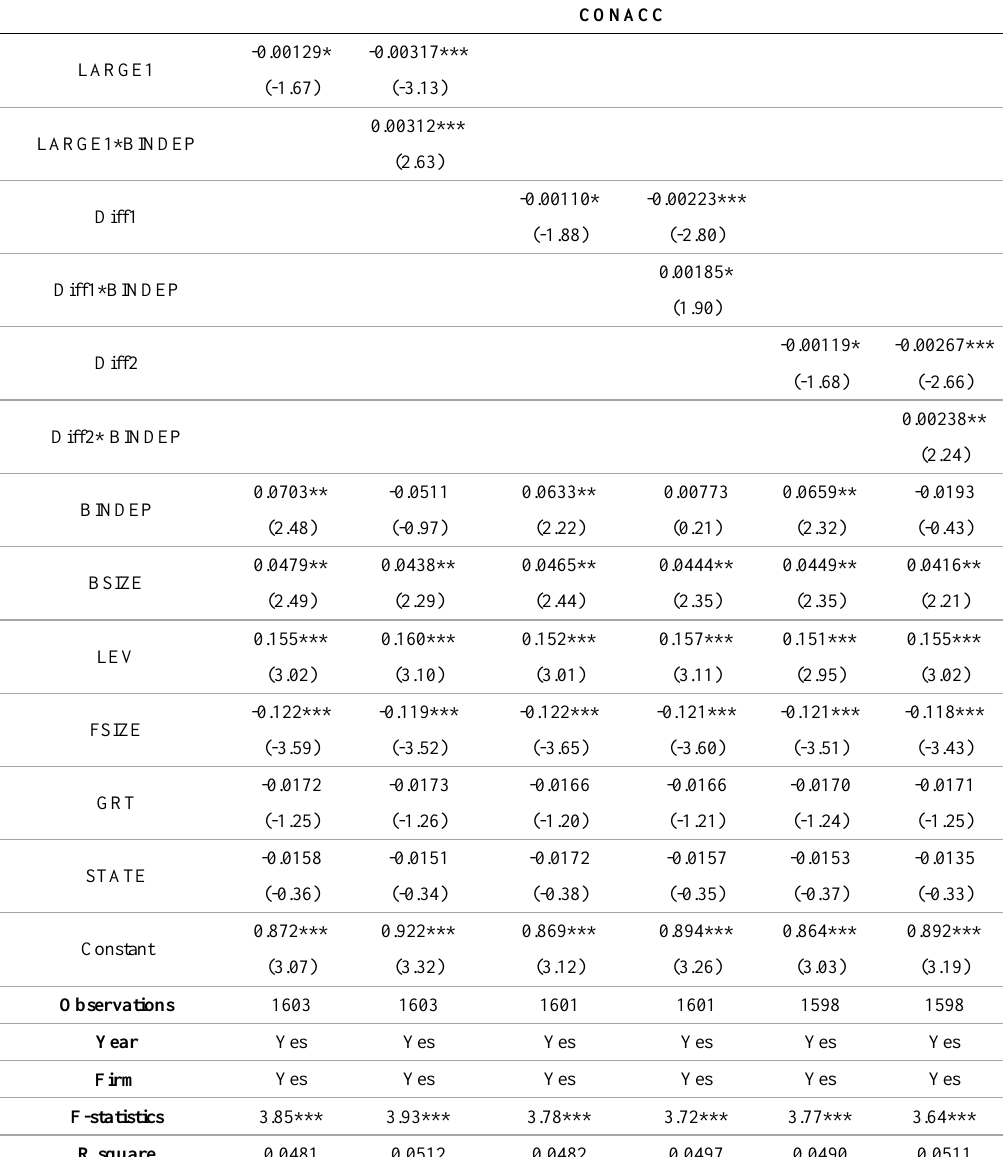
Table 5. Fixed effects